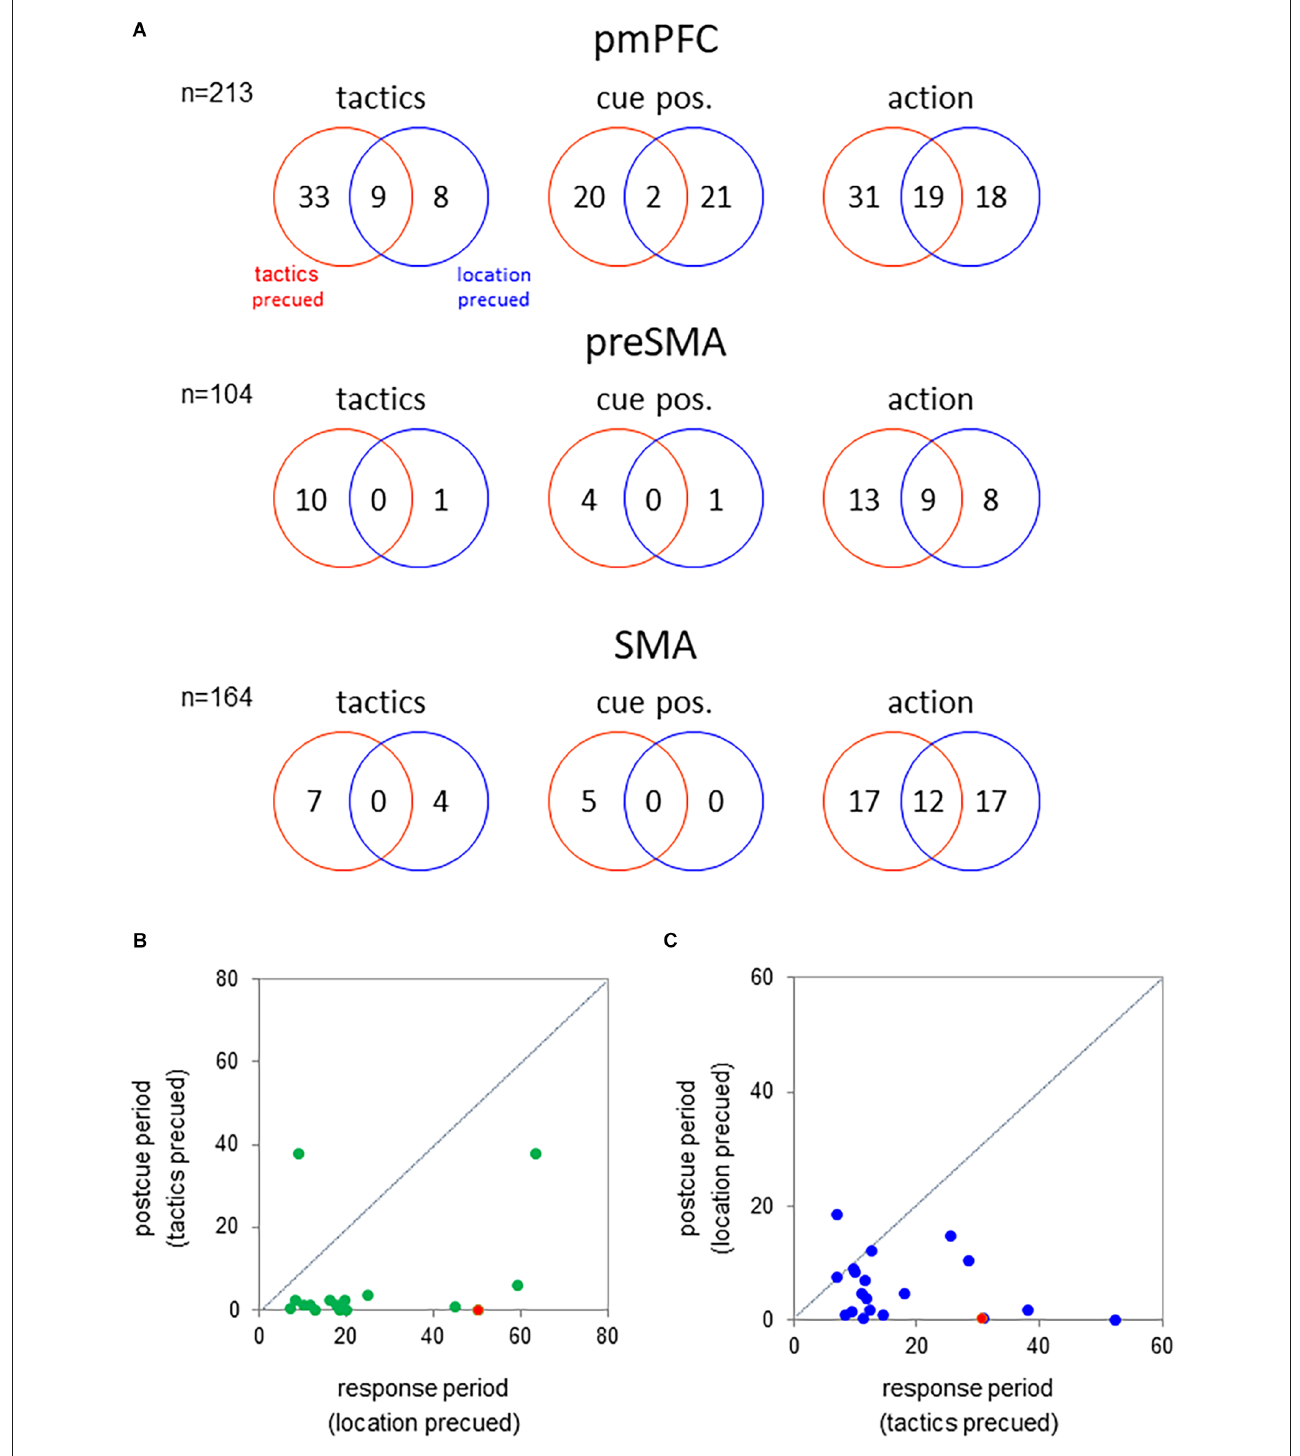
FIGURE4 (A) Numberofneuronsshowingsignificanteffectoftactics(left),cueposition(middle),andaction(right)ontheactivityduringtheresponseperiod(300ms before hold release) of the tactics- and location-precued tasks ( p < 0.01 by multifactorial ANOVA). Top —pmPFC; middle —pre-SMA; bottom —SMA. (B) Comparison of the tactics-selectivity of the neuronal activity following the onset of the tactics cue between the different task periods. abcissa — f -value of the multifactorial ANOVA using the tactics as the factor during the response period of the location-precued task; ordinate — f -value during the post-cue period of the tactics-precued task. The green circles represent the pmPFC neurons that encoded tactics during the response period of the location- precued task. The red circle represents the neuron in Figure 3 . The mean value during the response period was significantly greater than that in the post-cue period ( p < 0.001 by the two-tailed Kolmogorov-Smirnov test). (C) Comparison of the location-selectivity of the neuronal activity following the onset of the tactics cue between the different task periods. Legends are the same as in B except that the abscissa and the ordinate are the f -values of the ANOVA using the cue location as the factor. Blue circles —pmPFC neurons that encoded the location during the response period of the tactics-precued task; Red circle —the pmPFC neuron in Figure 2 . The mean value was significantly greater in the response than in the post-cue period ( p < 0.001 by two-tailed Kolmogorov-Smirnov